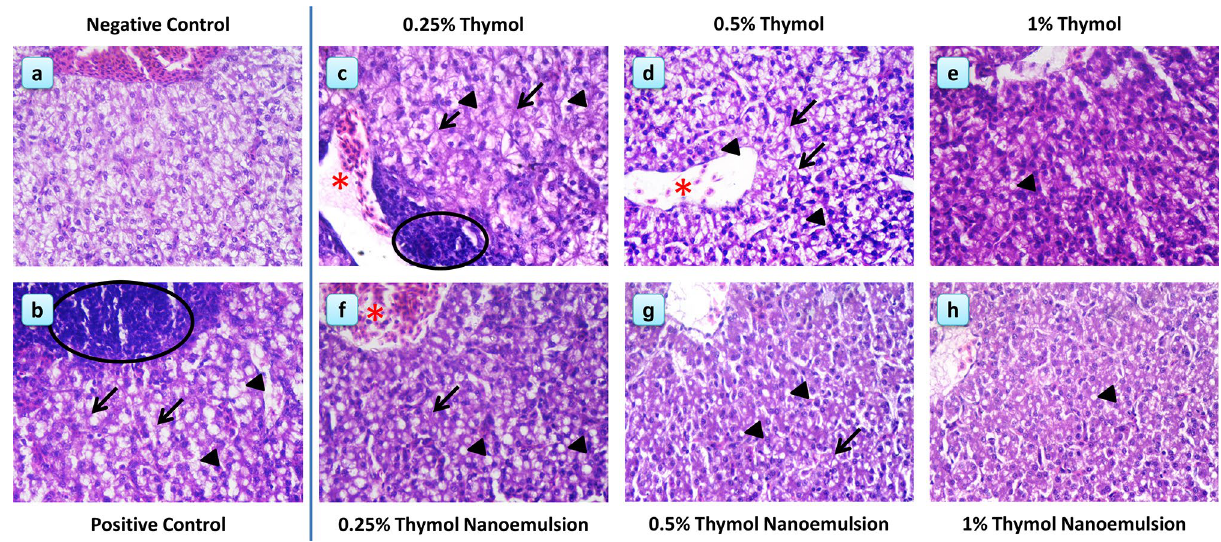
Figure 8. Histological and histopathological alteration of the liver at 14 days post-infection. ( a ) negative control: birds fed basal diet without challenge with S. Typhimurium; ( b ) positive control: birds fed basal diet and challenged with S . Typhimurium; ( c ) birds fed basal diet supplemented with 0.25% thymol, ( d ) birds fed basal diet supplemented with 0.5% thymol; ( e ) birds fed basal diet supplemented with 1% thymol; ( f ) birds fed basal diet supplemented with 0.25% thymol nanoemulsion; ( g ) birds fed basal diet supplemented with 0.5% thymol nanoemulsion; ( h ) birds fed basal diet supplemented with 1% thymol nanoemulsion. Focal leukocytic infiltration (circle), hydropic degeneration (arrow), vacuolation (arrow head), dilated hepatic blood vessels (red asterisk), and perivascular or interstitial leukocytic infiltration (arrows). Stain H&E (magnification, 400